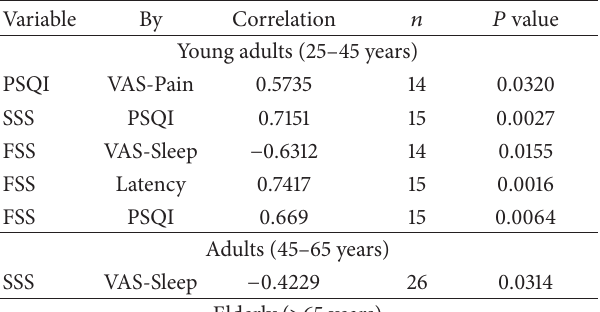
Table 2: Significant correlations of CTS and sleep parameters by age